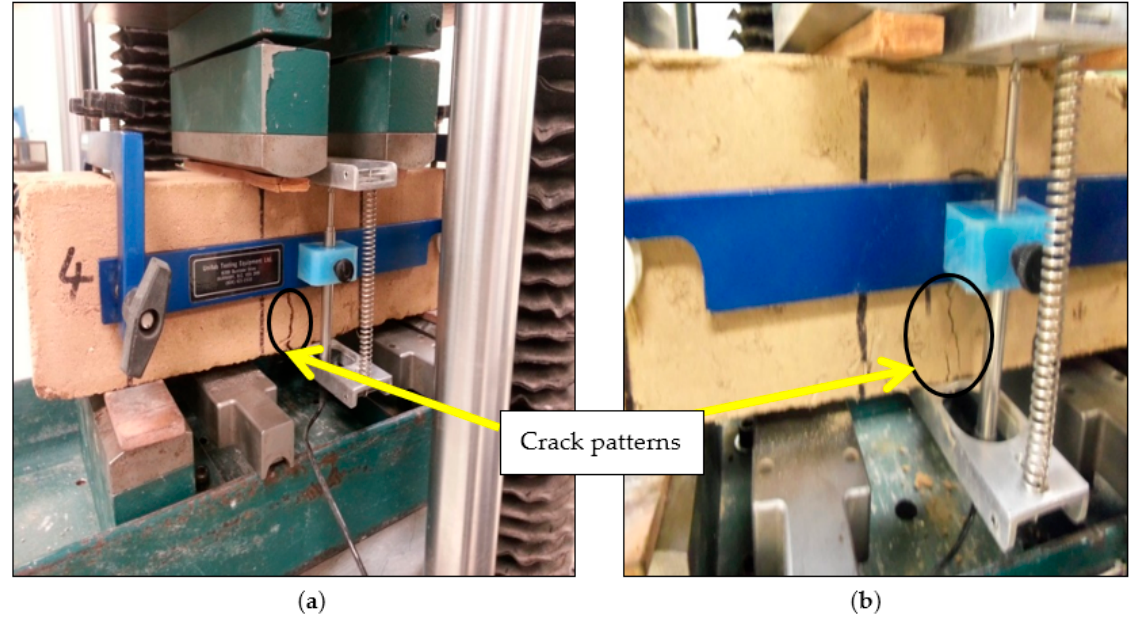
Figure 7. Typical crack patterns: ( a ) beams reinforced with 0.2 and 0.4% fibers, ( b ) beams reinforced with 0.6, 0.8, and 1.0% fibers.